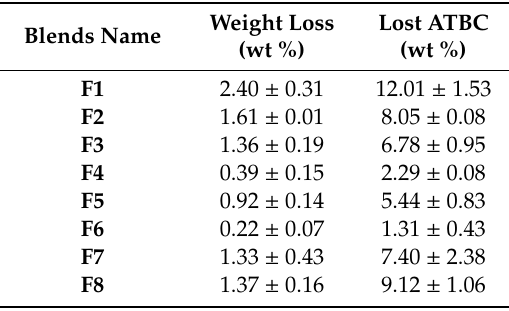
Table 2. Film weight loss and ATBC lost, calculated according to Equations (2) and (3), for all film